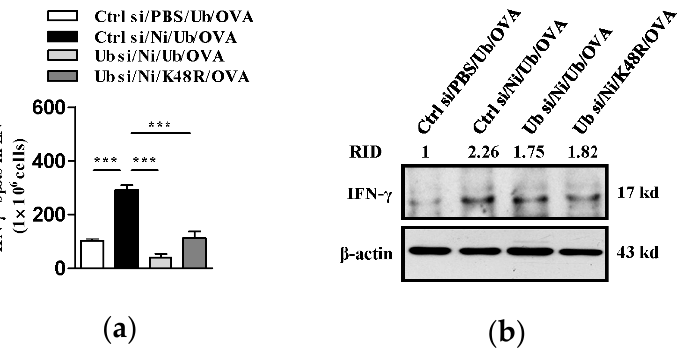
Figure 3. K48-linked ubiquitination contributes to nicotine-augmented dendritic cell-based CTL priming. ( a , b ) Murine ubiquitin deficient and control BM-DC were stimulated with nicotine (10 − 7 mol/L) for 12~16 h. Then, the cells were replenished with K48R-Ub or WT-Ub (30 × 10 − 6 mol/L) and further incubated with ovalbumin (50 µ g/mL) for 5~6 h. After that, 1 × 10 5 BM-DC was intraperitoneally transferred into C57BL/6 recipients. 5~7 d after adoptive transfer, splenocytes and lymph nodes of the recipients were prepared. Antigen-specific CTL in the lymph nodes was determined by IFN- γ Elispot assay ( a ). IFN- γ expression in splenocytes was determined by Western blot analyses ( b ). For Western blot analyses, β -actin was used as an internal control. Protein level was quantified by ImageJ software and presented as related integrated density (RID). One representative from three independent experiments is shown. Data were presented as the mean ± SEM of replicates from one experiment. *** p < 0.001, one-way ANOVA with Newman-Keulspost test.